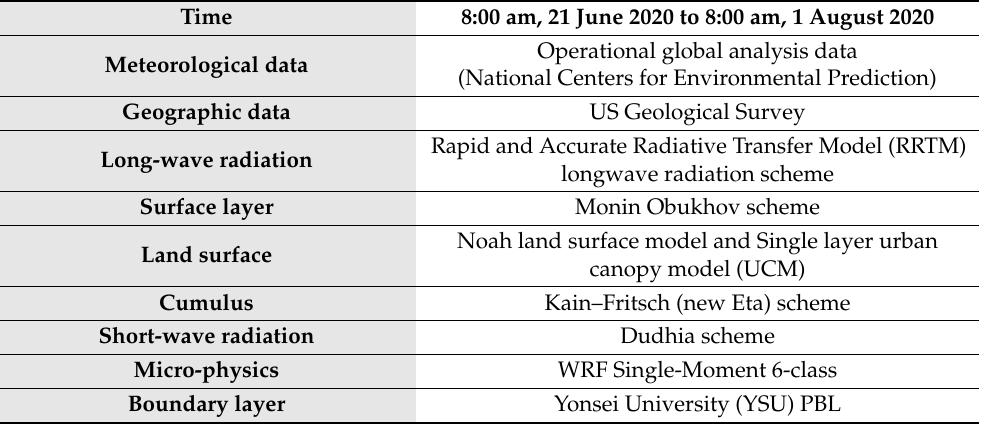
Table 2. WRF configurations.